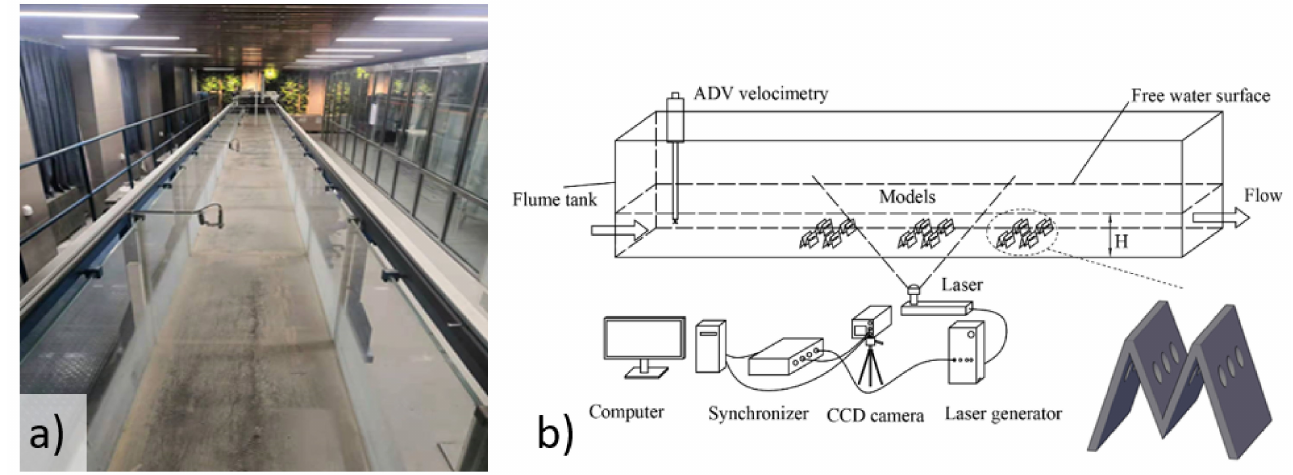
Figure 2. ( a ) Upstream view of the experimental facility, ( b ) schematic diagram of the experimental flume and setup and 3D representation of M-Type artificial reefs